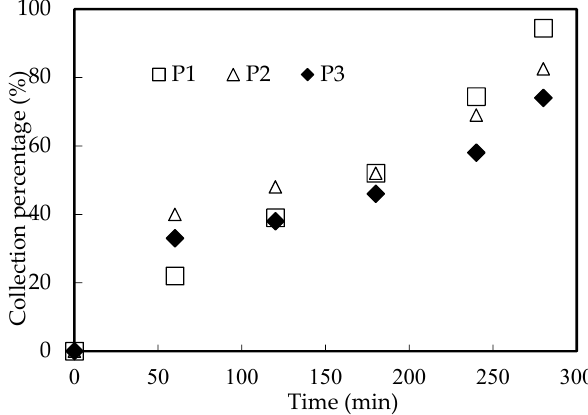
Figure 13. Influence of tube–shell thickness.